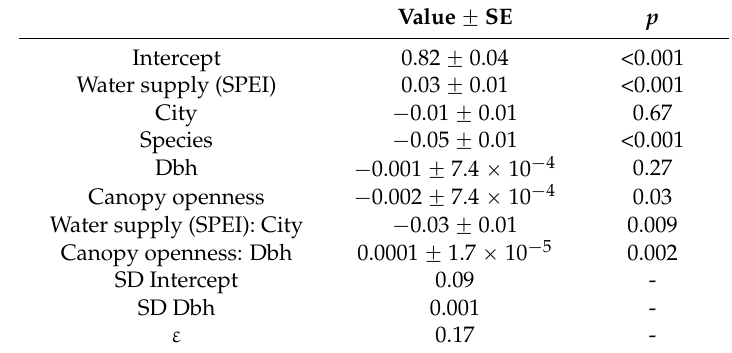
Table 4. Linear mixed model on ring width index (RWI) development of all years with an index < 1 (growth lower than normal, drought years) of all analyzed trees as the response variable with the individual tree code as a random effect and a random slope added for the effect of dbh, and fixed effects water supply (measured with SPEI), canopy openness, analyzed species, growing city, and dbh of the form: RWI ij = β 1 ˆ x 1 ij + . . . + β n ˆ x nij + b i 1 ˆ z 1 ij + . . . + b in ˆ z nij + ε ij where RWI is